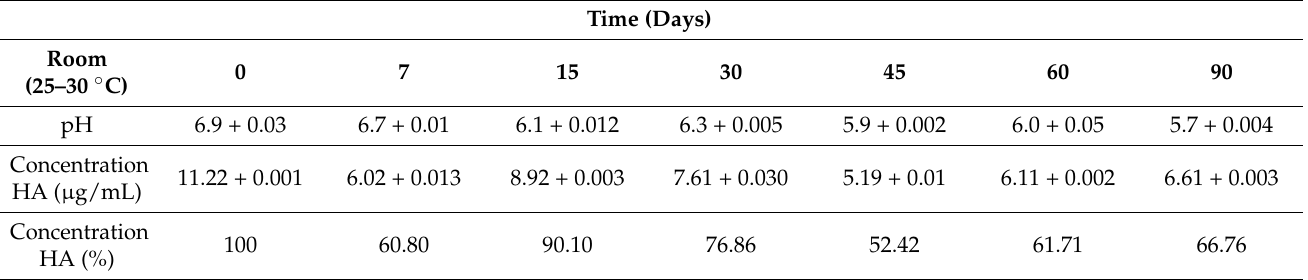
Table 1. Physicochemical characteristics of OG + HA stored at room temperature for 90 days.